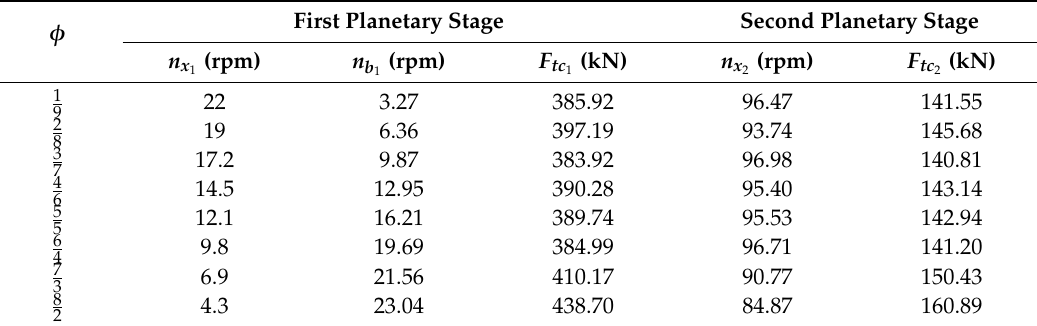
Table 7. The tangential force on the pitch circle of planet gear of DRWT.